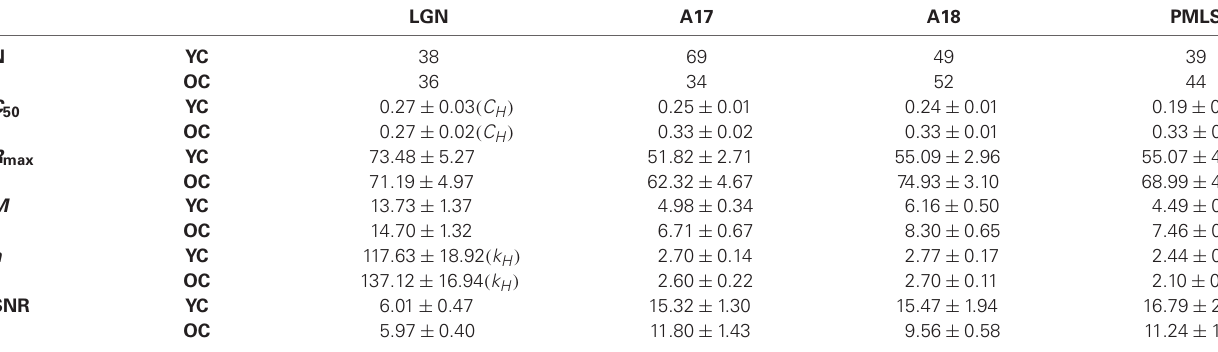
Table 1 | Visual response properties of each brain area for YC and OC